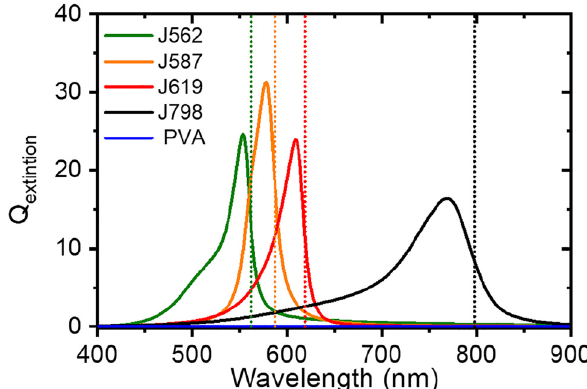
Figure 4: Normalised extinction efficiency cross section of simulated LH2 nanorings composed of only pure PVA (blue) and J-aggregate:PVA materials obtained via a combination of J562, J587, J619 or J798 with PVA. The coloured dotted line corresponds to the absorption peak of the bulk polaritonic materials (see Table